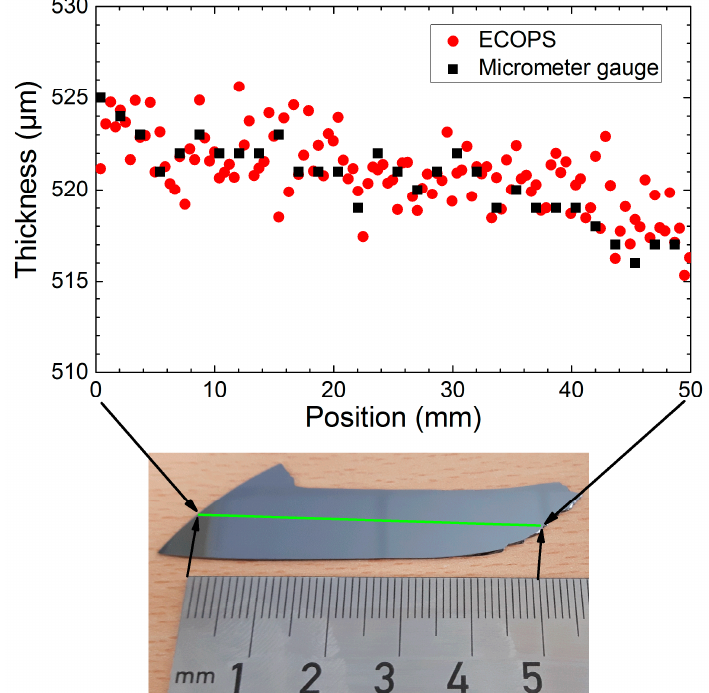
Figure 8. ECOPS-based thickness measurement of a moving silicon wafer (red). Selected spots on the same sample (not rotating) were measured with the micrometer gauge for comparison (black). The green line in the photograph marks the approximate positions of the measured spots.